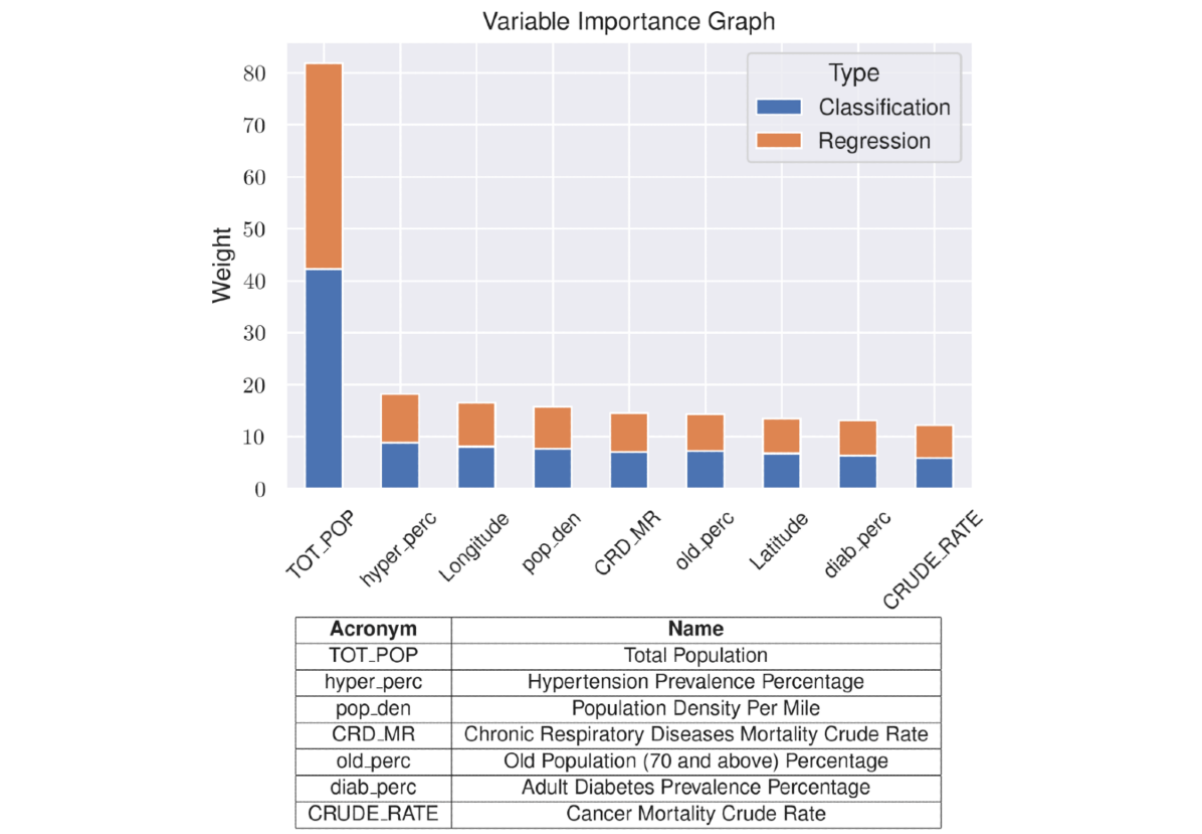
Figure 1. Variable importance for the classification and regression models.